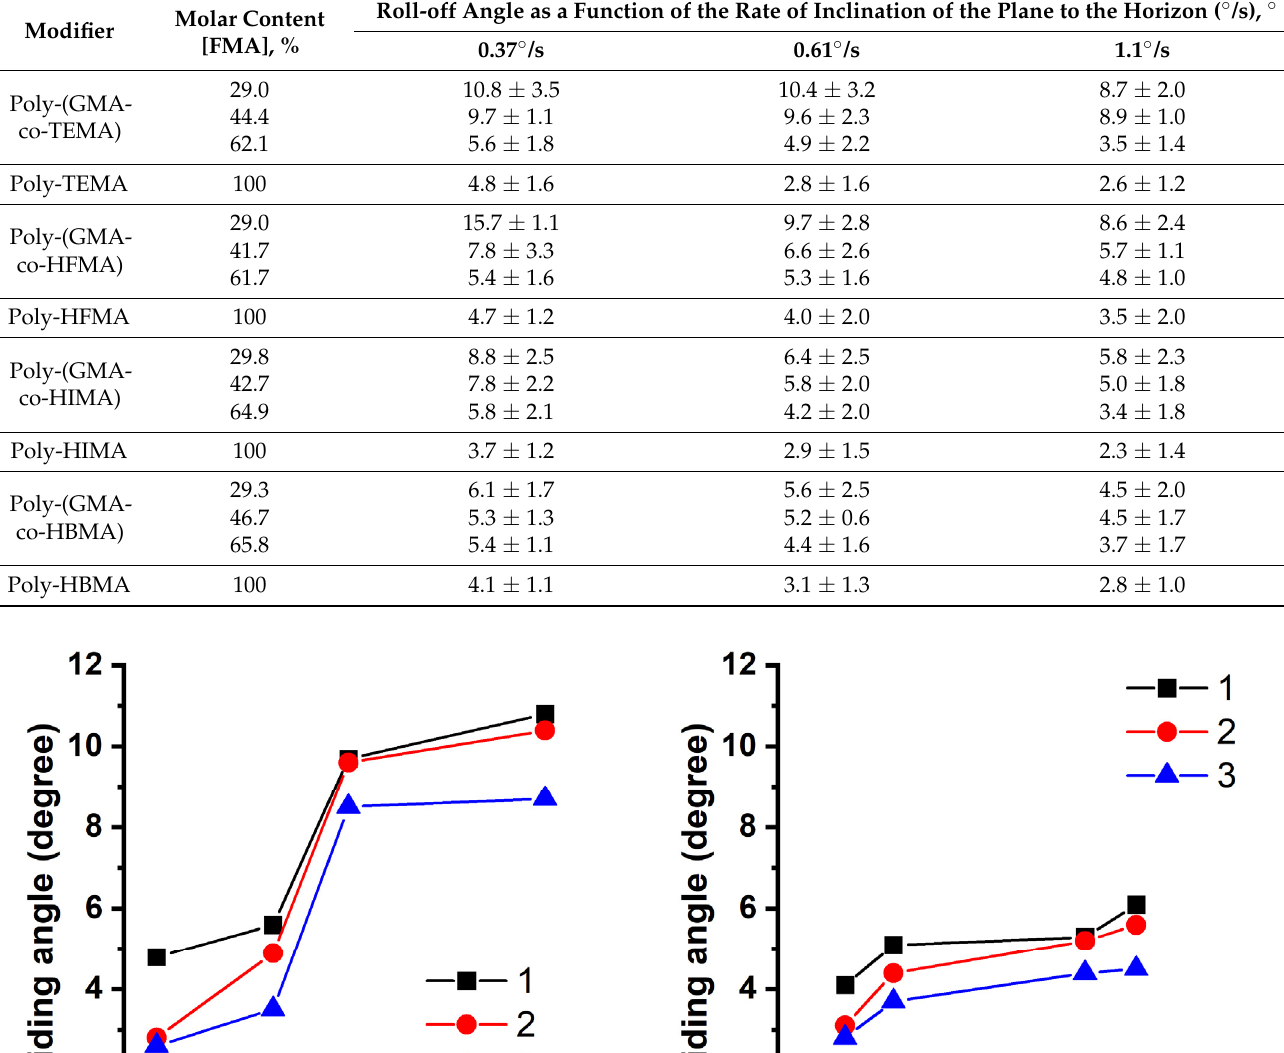
Table 5. Roll-off angle of water droplets from the aluminum surface modified with GMA- and FMA-based copolymers with a changing rate of inclination of the plane to the horizon.